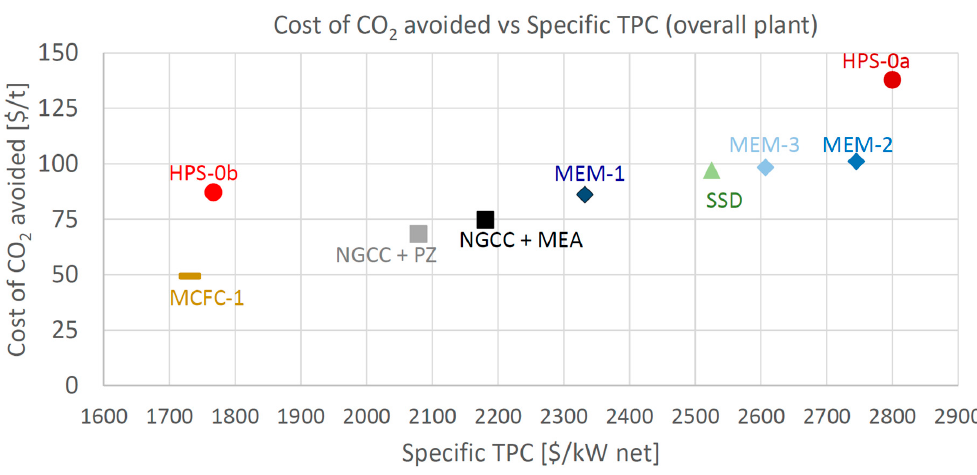
Figure 8. Cost of CO 2 avoided vs. Specific TPC.